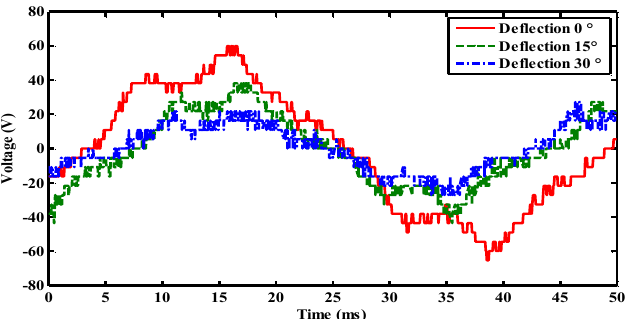
Figure 31. Phase voltage comparison diagram of phase A winding in three states, based on the experiment.